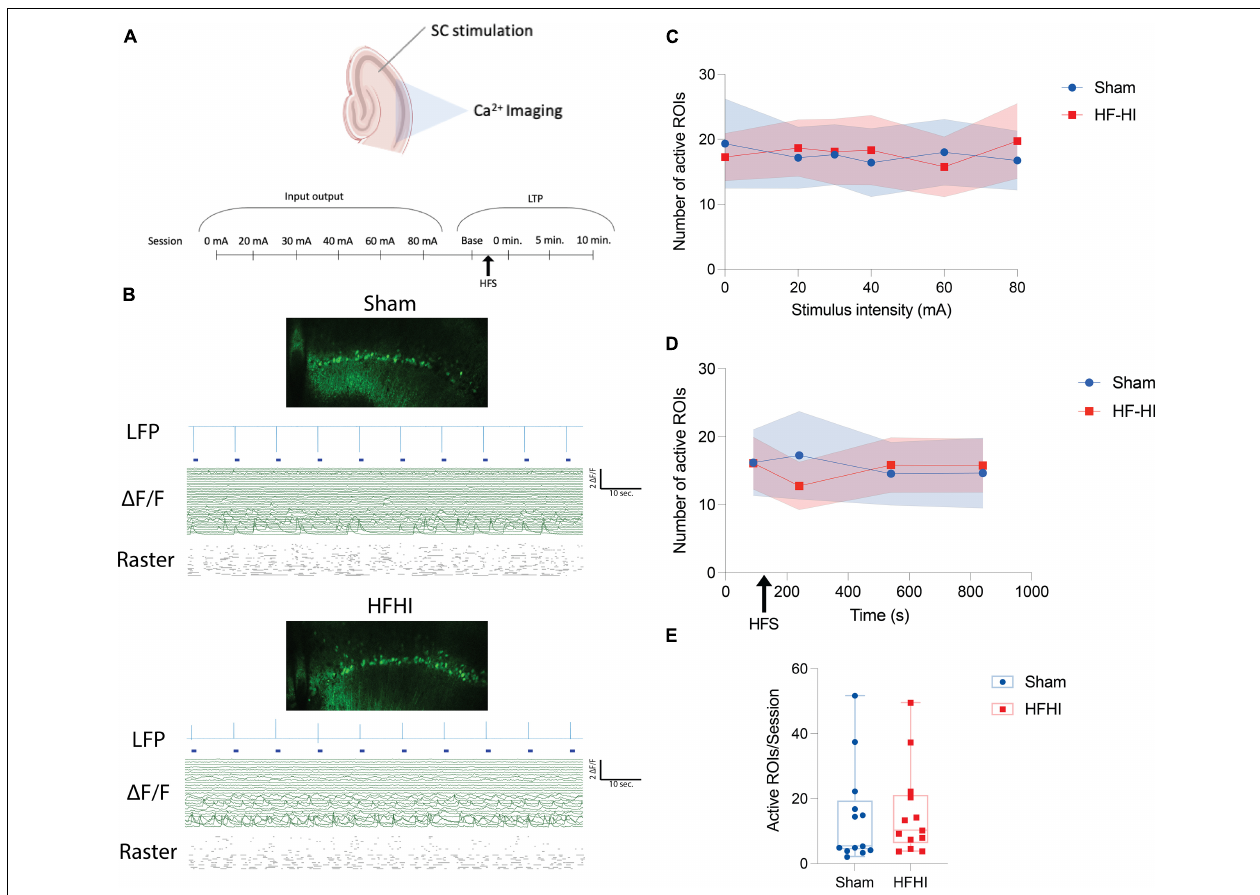
FIGURE 2 | High Frequency Head Impact (HFHI) does not alter number of ROIs with calcium activity. (A) Acute slices from Thy1-GcAMP6f mice were prepared 24 h following the last day of HFHI and calcium imaging of the CA1 field was performed during an abbreviated LTP paradigm. (B) Example confocal view, aligned LFP, raw calcium traces, and raster plot of sham (top) and HFHI (bottom) slices. (C) Semi-automatic ROI extraction revealed no differences in the number of ROIs with activity during the input output sessions, (D) LTP sessions, or (E) overall number of ROIs extracted per session. Shaded regions represent mean ± SEM in line graphs. n Sham = 13, n HFHI =